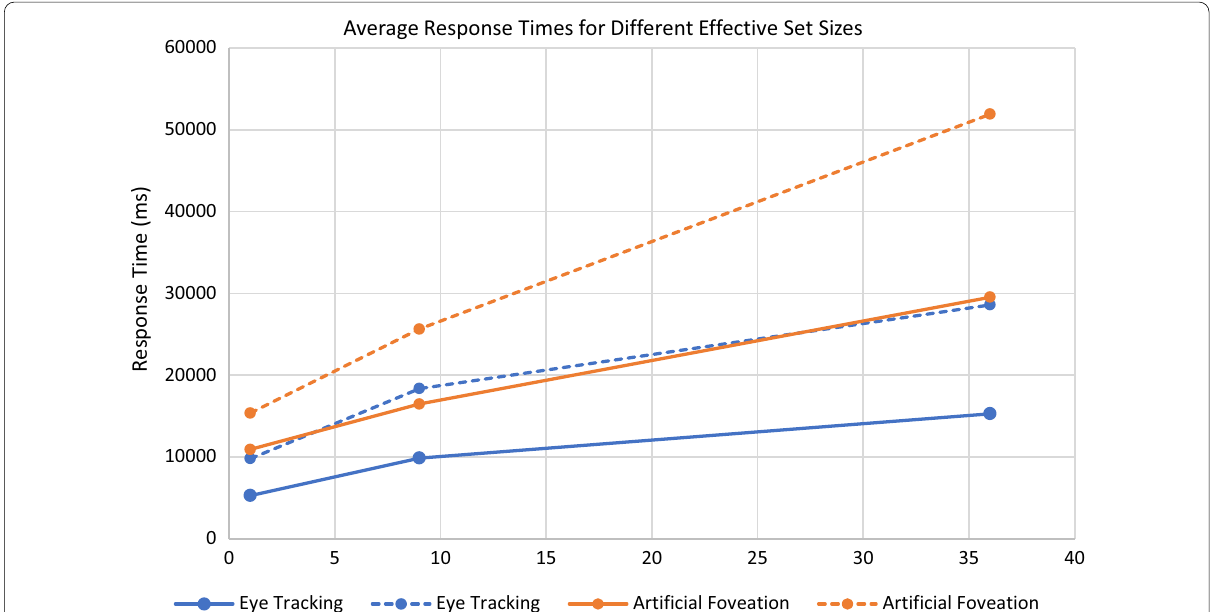
Fig. 5 The average response times for the eye tracking (blue) and artificial foveation (orange) experiments when the effective set size for the search task was 1, 9, and 36. The solid lines show the trials in which participants checked off a Match item and the dashed lines show the trials in which participants checked off a Missing